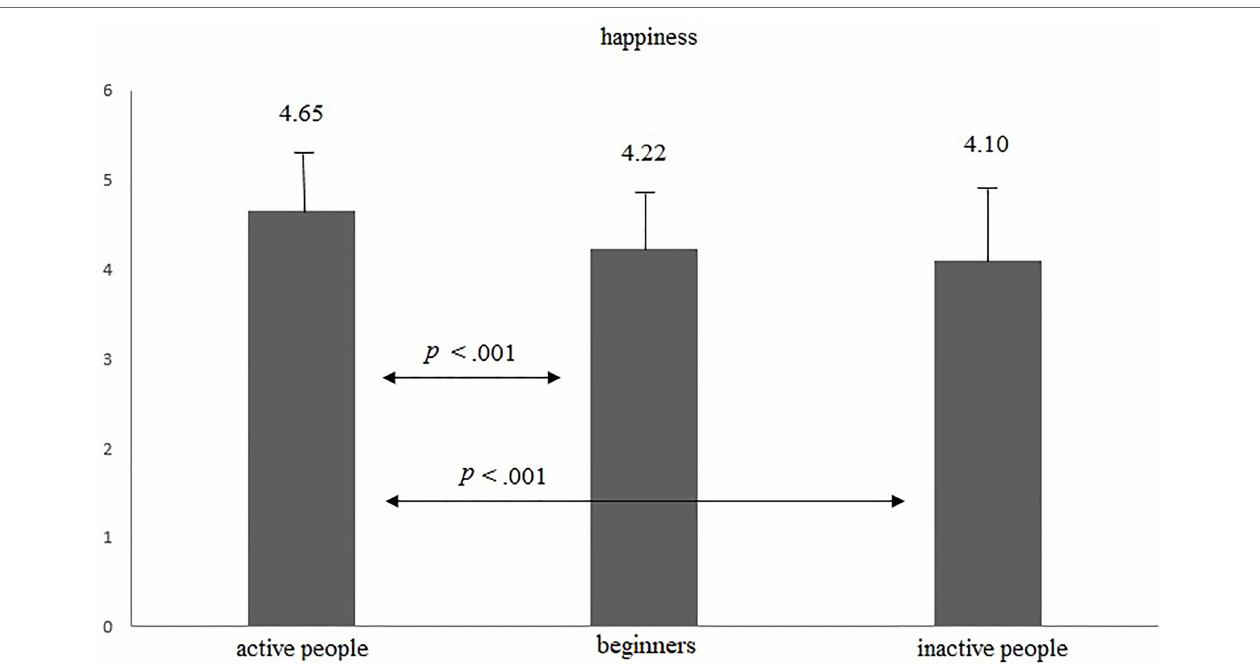
FIGURE 1 | Average level of happiness in groups of active people, beginners, and inactive